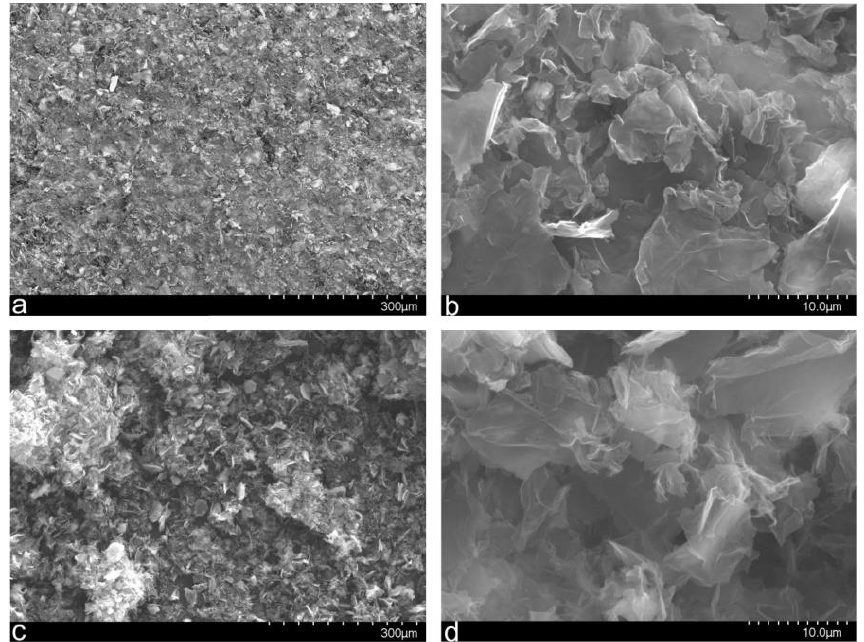
Figure 1. SEM micrographs showing the morphological aspects of the two graphene samples: overview and detailed view of the NSGr-120 sample, indicating a more compact and a relatively uniform distribution of the graphene flakes ( a , b ); overview and detailed view of the NSGr-200 sample, indicating a laxer distribution, and larger flakes compared to the first sample ( c , d ).